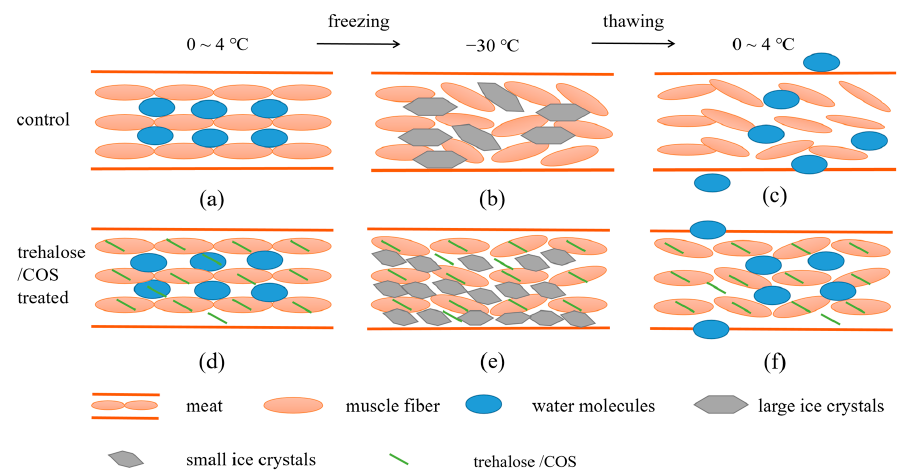
Figure 7. The schematic diagram of the underlying mechanisms of the trehalose/COS treatments affecting the thawing loss of frozen meat. In the image, ( a – c ) represented meat, ( d – f ) represented meat treated with trehalose/COS. ( a , d ) represented meat before frozen. ( b , e ) represented meat under frozen situation; ( c , f ) represented meat during thawing. The ice crystals were smaller and the muscle fibers were well protected after meat was treated with trehalose/COS, and thus the water was held better by the muscle fibers.